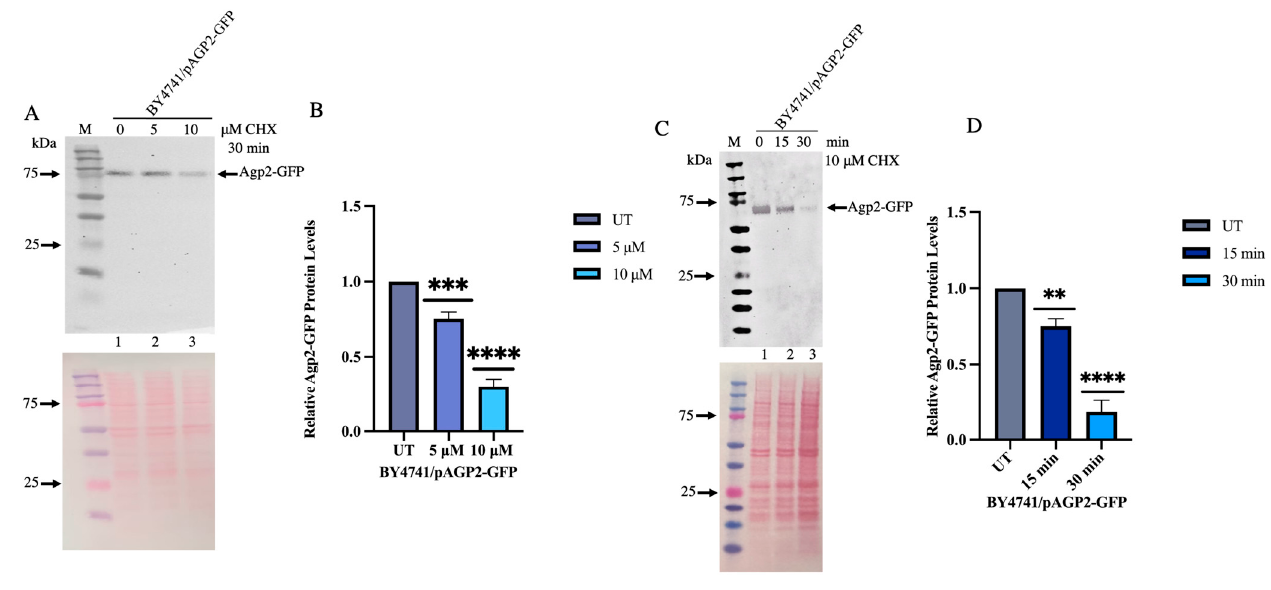
Figure 5. Immunoblot showing Agp2-GFP is disappearing upon exposure to CHX. ( A ) Immunoblot analysis of cells treated with increasing concentrations of CHX. Exponentially growing cells from the wild type (WT) (strain BY4741) expressing Agp2-GFP were treated with 0 to 10 µM CHX for 30 min, followed by crude plasma membrane preparation (see “Materials and Methods”) and analysis by immunoblot probed with anti-GFP antibodies. Ponceau staining was performed to monitor for protein loading. ( B ) Quantification of the disappearance of Agp2-GFP relative to the untreated sample (lane 1). ( C ) Immunoblot analysis of cells treated with a fixed concentration of CHX at different times. The samples were processed as in panel A , showing Ponceau staining below and ( D ) quanti- fi cation of Agp2 levels. M, prestained protein markers in kDa. Results are representative of three independent experiments. Error bars indicate S.E. The data are representative of three biological replicates and analyzed by 2-way Anova Test. ** Is equivalent to p -value < 0.01, *** Is equivalent to p -value < 0.001, **** Is equivalent to p -value < 0.0001